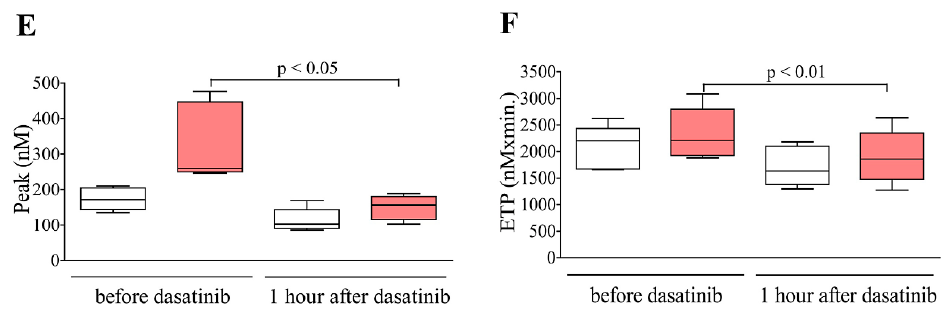
Figure 3. Treatment of chronic myeloid leukemia (CML) patients with dasatinib suppresses PS exposure and generation of thrombin in PRP. Blood was collected from dasatinib treated CML patients ( n = 5) before and at 1 h after witnessed drug administration. Platelets of patients were stimulated with 12.5 ng / mL convulxin for 15 min in PRP. PS exposure ( A ) and thrombin generation were investigated. Panel ( B ) shows representative overlay thrombin generation curves. Time parameters of thrombin generation, lagtime ( C ); time to peak ( D ); and quantity of generated thrombin, peak ( E ) and ETP ( F ), were evaluated.